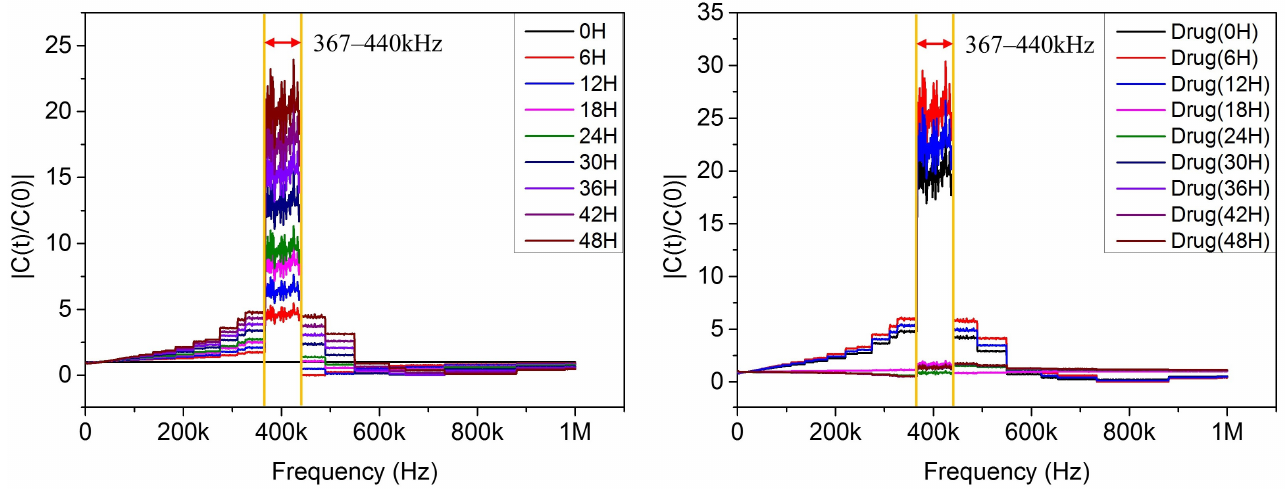
Figure 3. The graph of measuring capacitance by frequency sweep on cell growth ( left ) and death ( right ) state.